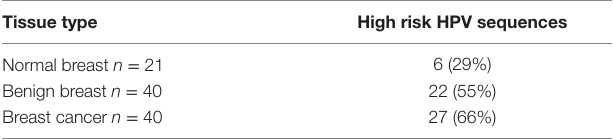
TaBle 3 | identification by Pcr of high risk for cancer hPVs in normal breast (source cosmetic surgery), benign breast and breast cancer (same patients with prior benign breast and subsequent breast